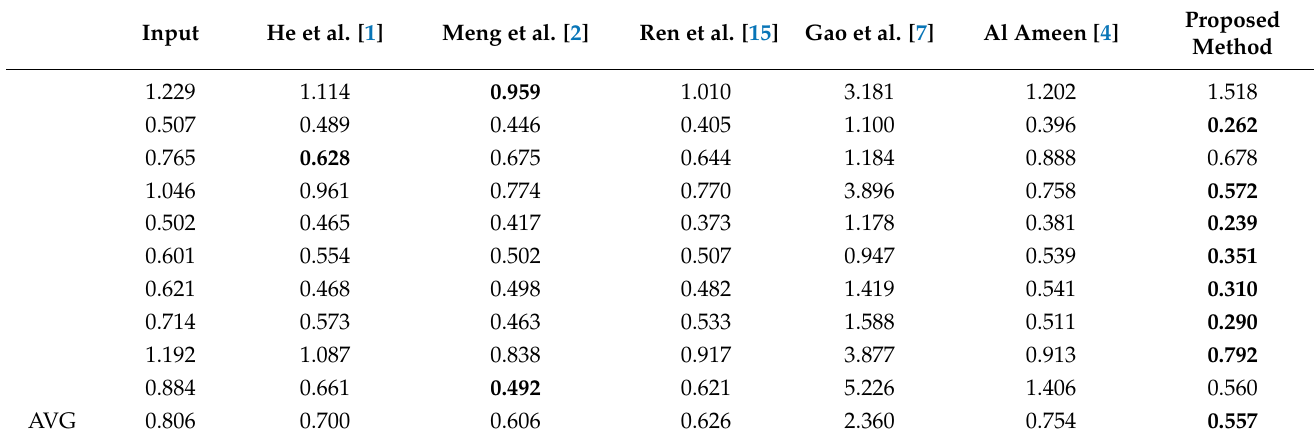
Table 8. The comparison of the FADE [36] scores from Figure 7 (If the score is low, the image is well enhanced. The lowest are indicated in bold ).